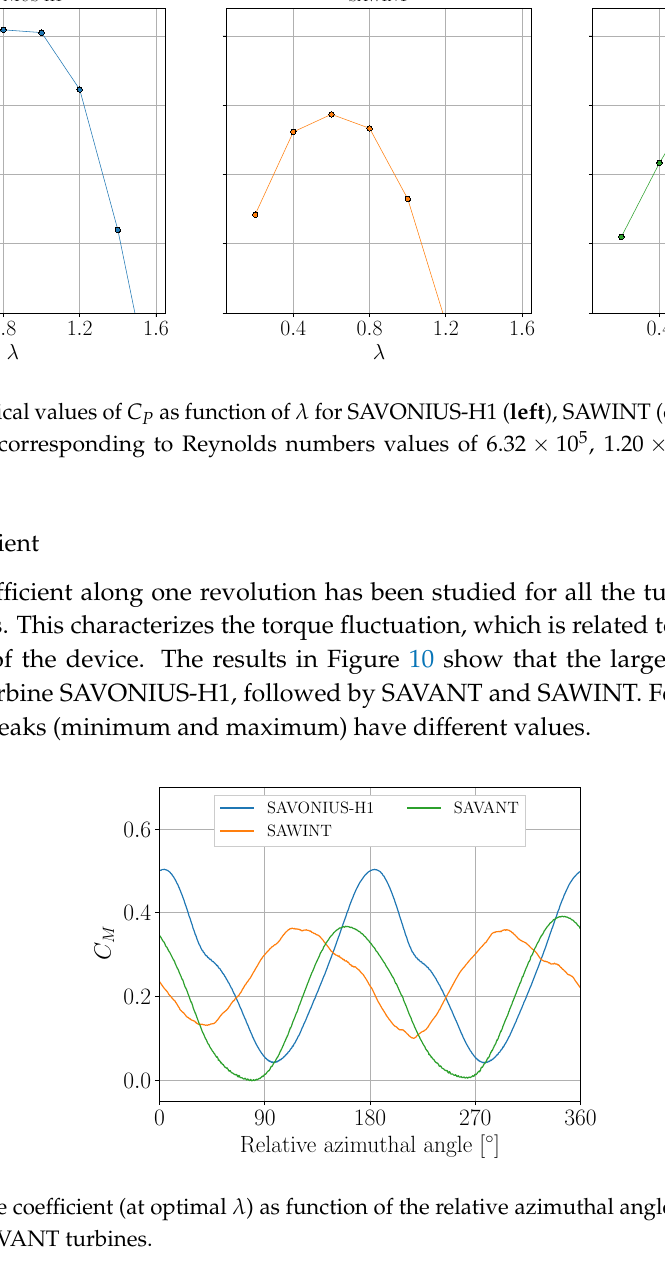
Figure 10. Torque coefficient (at optimal λ ) as function of the relative azimuthal angle for SAVONIUS-H1, SAWINT, and SAVANT